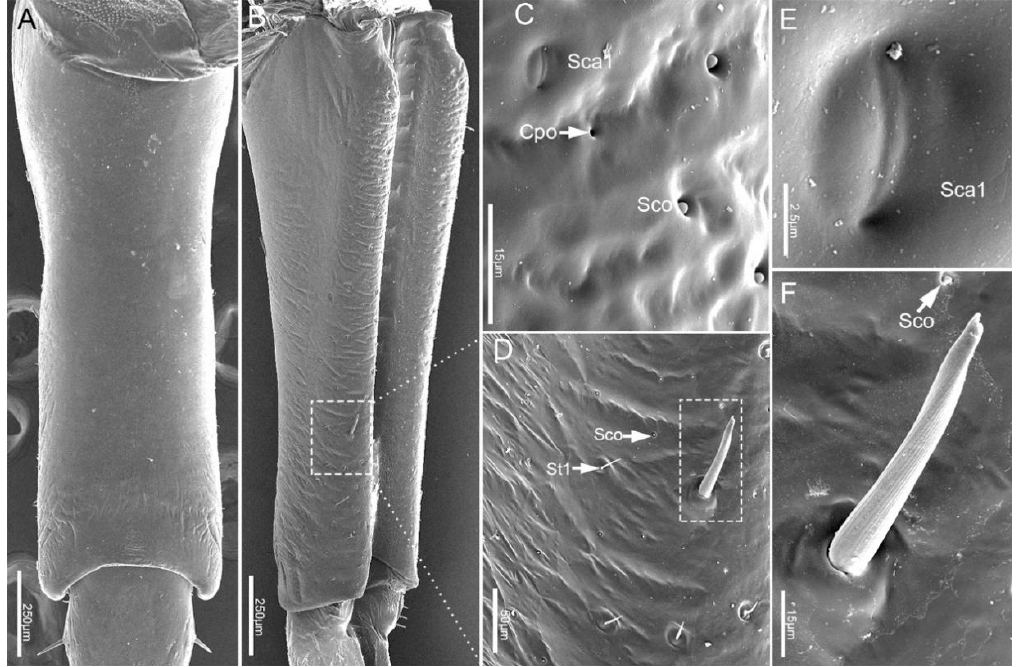
Figure 3. SEM of first labial segment of E. fullo . ( A ) Ventral view; ( B ) Lateral view; ( C ) Enlarged view of surface of the first segment, showing sensilla campaniformia 1 (Sca1), sensilla coeloconica (Sco) and cuticular pores (Cpo); ( D ) Enlarged view of outlined box in ( B ), showing sensilla trichodea 1 (St1), sensilla coeloconica (Sco) and sensilla basiconica 1 (Sb1); ( E ) Sensillum campaniformium 1 (Sca1); ( F ) Enlargement of outlined box in ( D ), showing sensillum coeloconicum (Sco) and sensillum basiconicum 1 (Sb1).